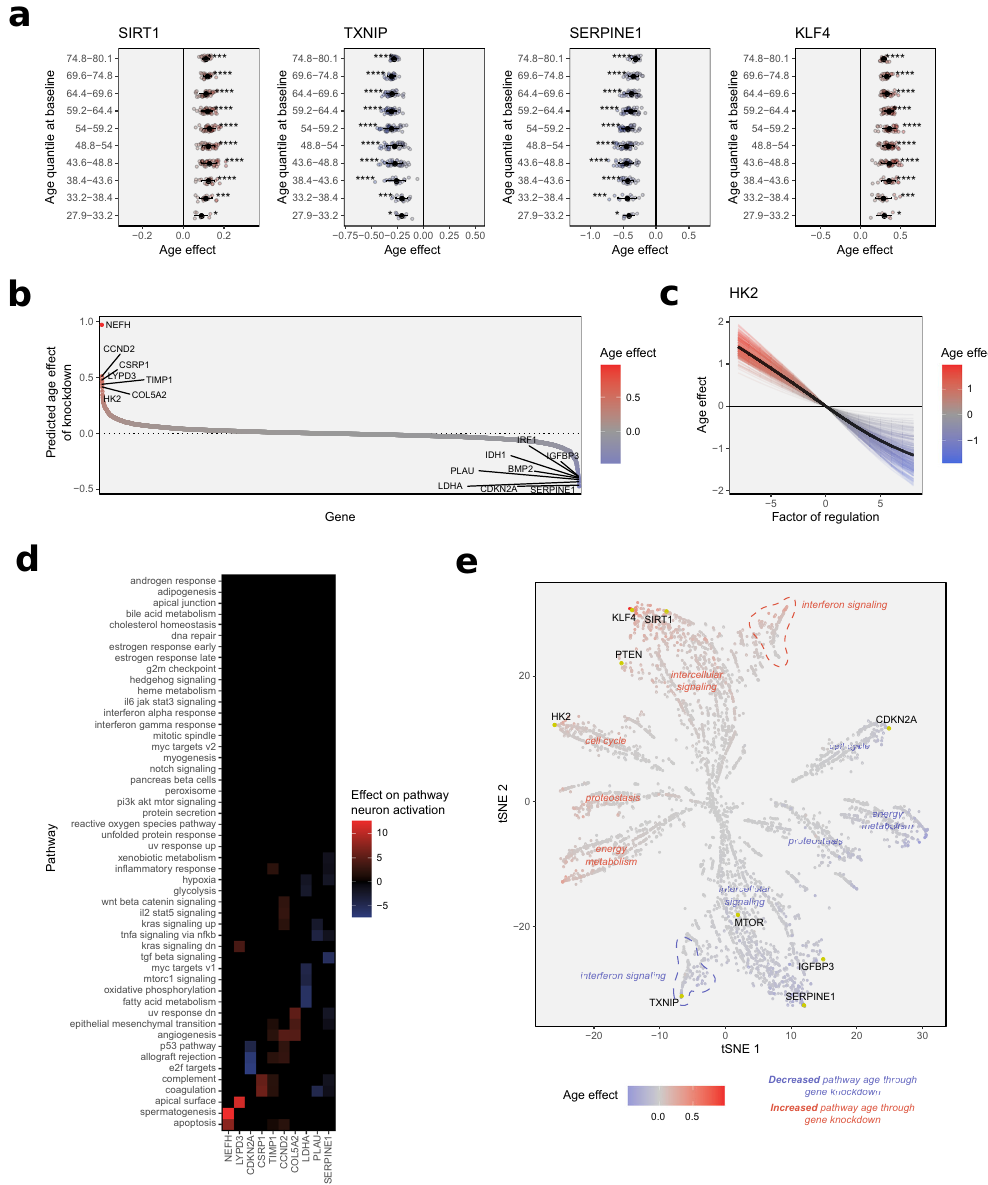
Fig. 3 Identifying relevant aging target genes through simulated gene perturbation. a Predicted effects of the in silico knockdowns of SIRT1, TXNIP, SERPINE1, and KLF4. Effect on age is strati fi ed by chronological age quantiles of the test subjects. Signi fi cance was determined using one-sample Wilcoxon rank-sum tests, testing for the difference in medians from an effect size of 0, with p -values adjusted for multiple testing. Error bars show standard deviations. b Distribution of the predicted age effects of the in silico knockdown of all genes covered by the model. Genes at the upper and lower extremes can be regarded as the most important features of the model. c Predicted age effect of the simulated continuous knockdown and overexpression of HK2, one of the most important genes in the model. d Effects of simulated gene knockdowns by the most important genes according to impact on age estimation upon the activation of pathway neurons. e Two- dimensional embedding of the aging pathway landscape. The map was generated by assessing the effects of all gene knockdowns on pathway neuron activation and calculating a lower-dimensional embedding of the data using the tSNE algorithm. Genes are colored by the overall impact of their knockdown on the fi nal age estimate. Thereby clustering of genes according to strength and direction of correlation to age, as well as functional pathway annotation, can be research, in this case, the ability to test the relevance of target discovered so far, that links a single gene loss-of-function genes identi fi ed in a systemic context or in other tissues to the mutation directly with increased longevity in humans 27 . In line biology of aging skin, which the model was trained on. An with the literature, simulated knockdown of the senescence- example of a gene association more speci fi c to the skin however, associated gene lead to a signi fi cant decrease in transcriptomic is the knockdown of Krueppel-like Factor 4. KLF4 is, among others, age predicted by the model. These simulations, while intended a stemness factor and direct regulator of telomerase expression 28 , mainly as validation of the associations learned by the model, also highlight the utility of computational models for translational as well as importantly a regulator of keratinocyte senescence 29 . As